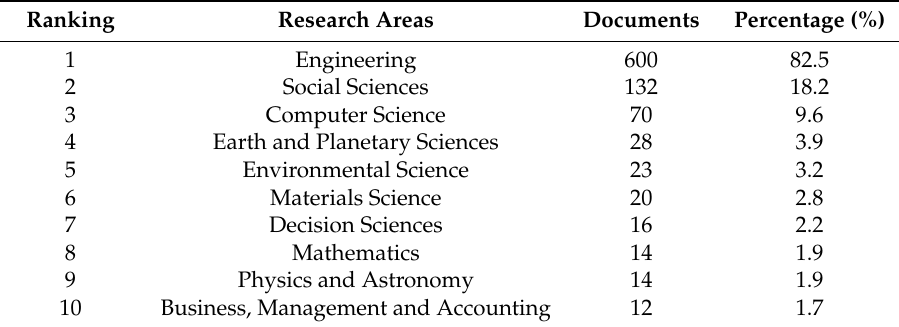
Table 5. The top 10 most popular subject